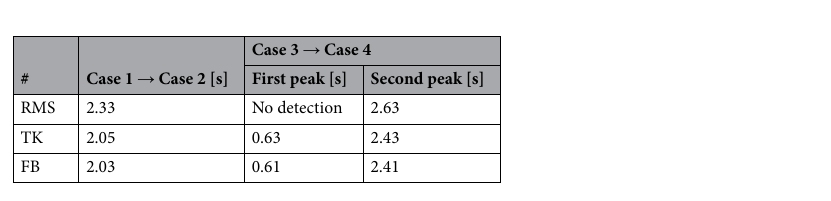
Table 7. Summary of detection times using RMS, TK, and